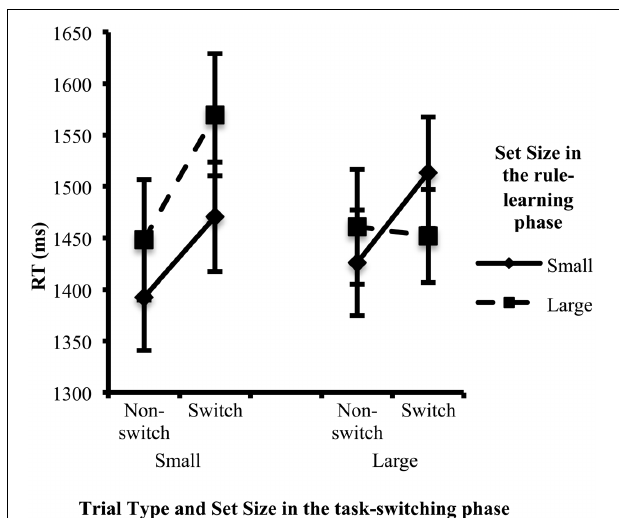
FIGURE 3 | Mean RT in the switch and non-switch trials as a function of the set size in the rule-learning and task-switching phases. Error bars indicate the standard error of the